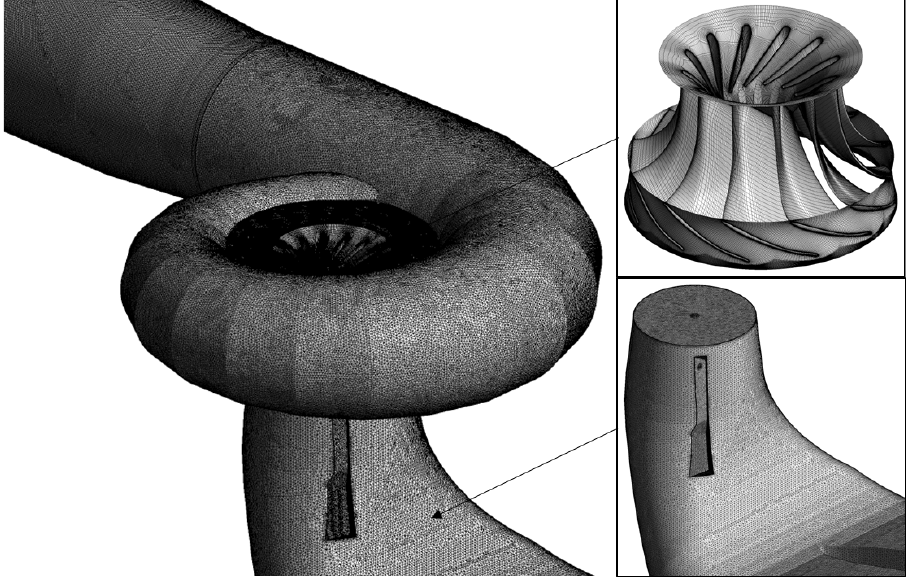
Energies 2020 , 13 , x FOR PEER REVIEW Figure 2. Numerical grids used in the Francis turbine model. Figure 2. Numerical grids used in the Francis turbine model.